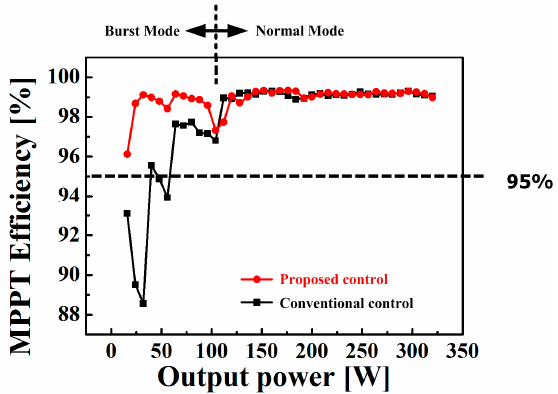
Figure 16. MPPT efficiency depending on control methods.